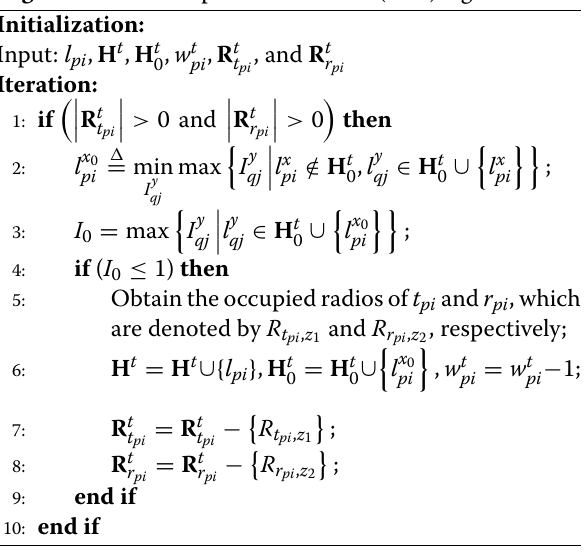
Algorithm 2 The tuple link selection (TLS) algorithm